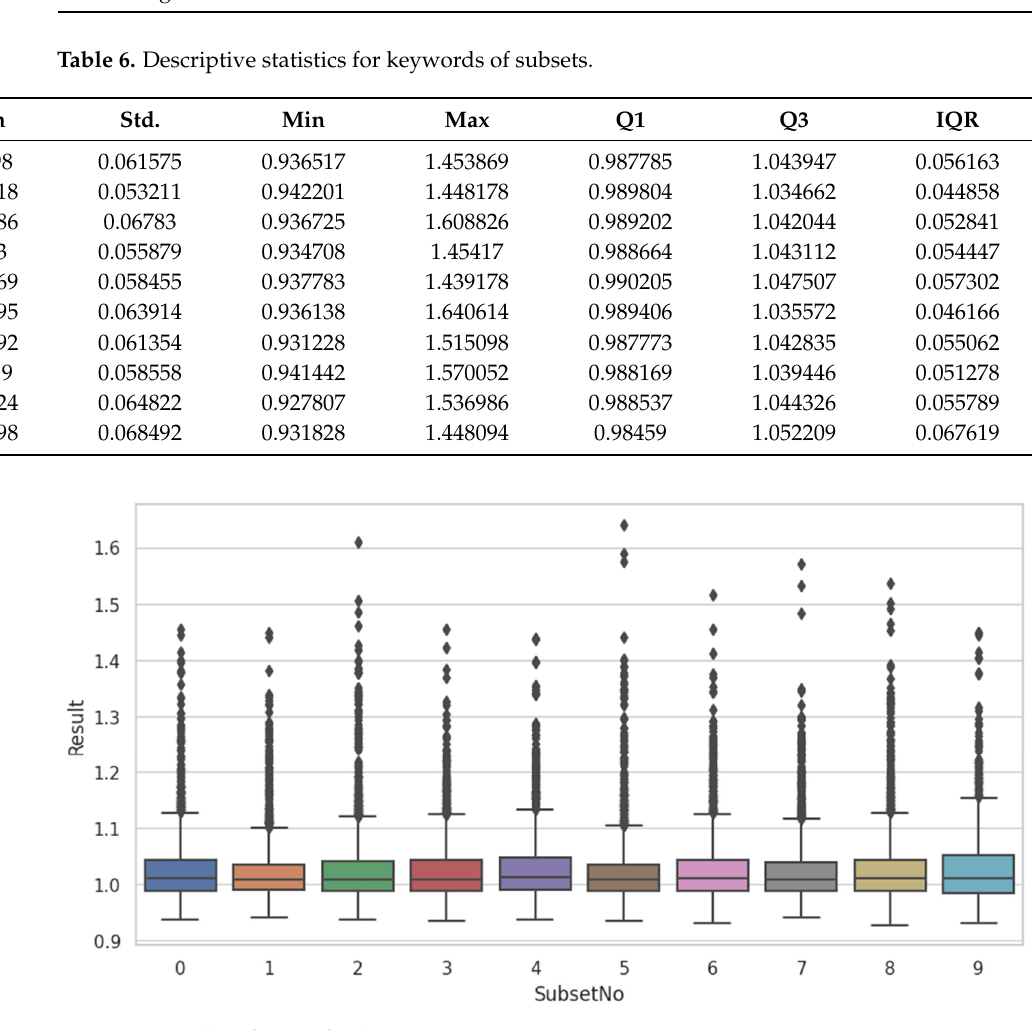
Figure 9. Boxplot of LOF of